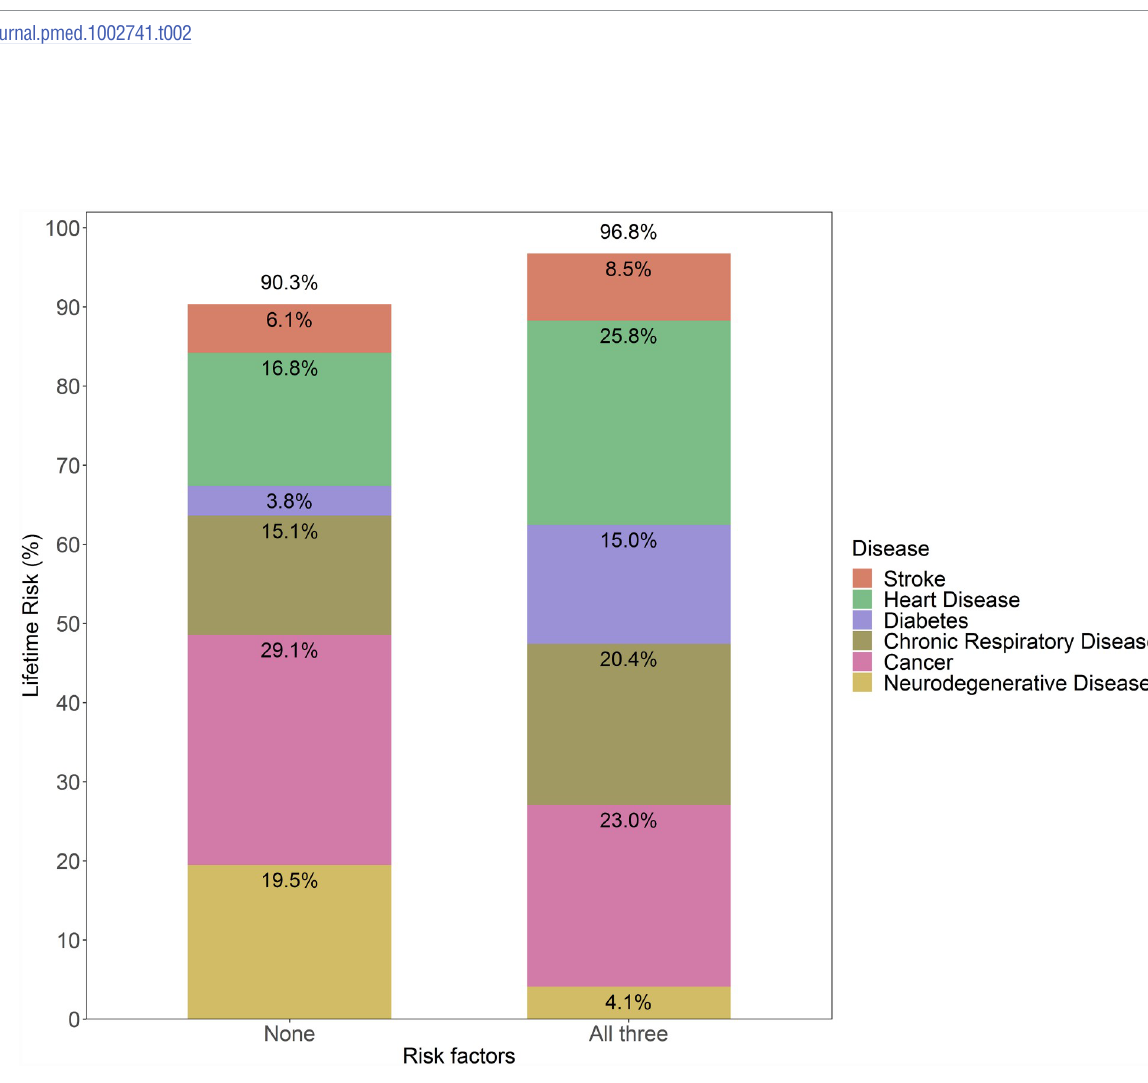
Fig 3. Lifetime risk of NCD stratified by risk factor burden. In this analysis, follow-up ended at the time of first occurrence of an NCD. For instance, for participants who first experienced heart disease and subsequently developed neurodegenerative disease, only heart disease is considered here. NCD, non-communicable